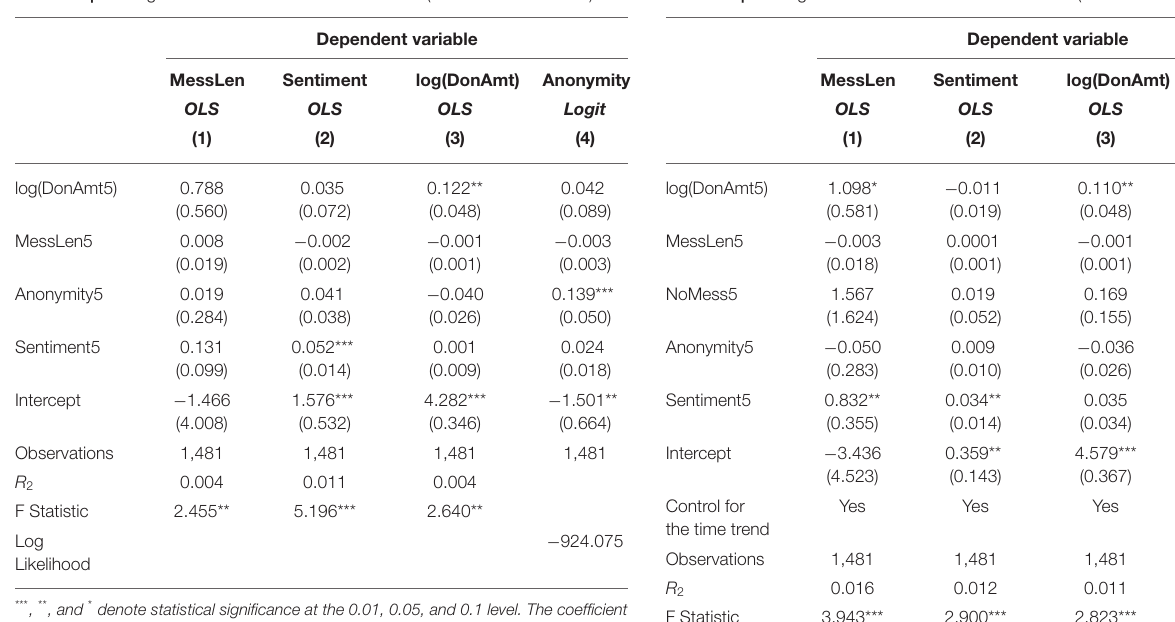
TABLE 4 | The regression results of donation behavior (MR sentiment scores). TABLE 5 | The regression results of donation behavior (time trend